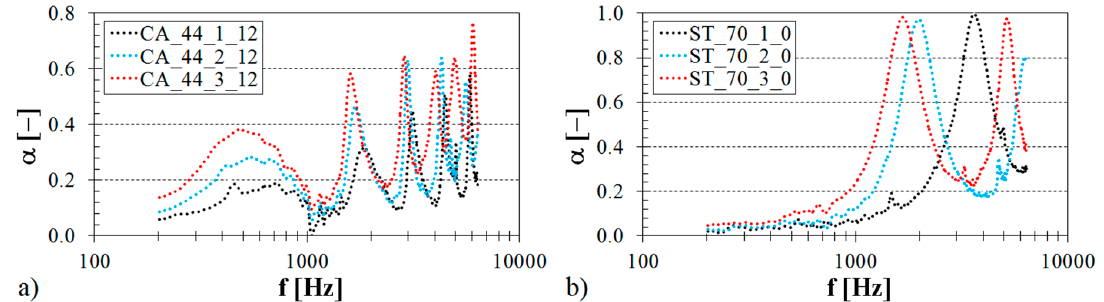
Figure 5. Influence of the sample thickness on the frequency dependencies of the sound absorption coefficient for the tested ABS samples: ( a ) Cartesian structure, volume ratio V r = 44%, air space size a = 12 cm; ( b ) Starlit structure, volume ratio V r = 70%, air space size a = 0 cm.